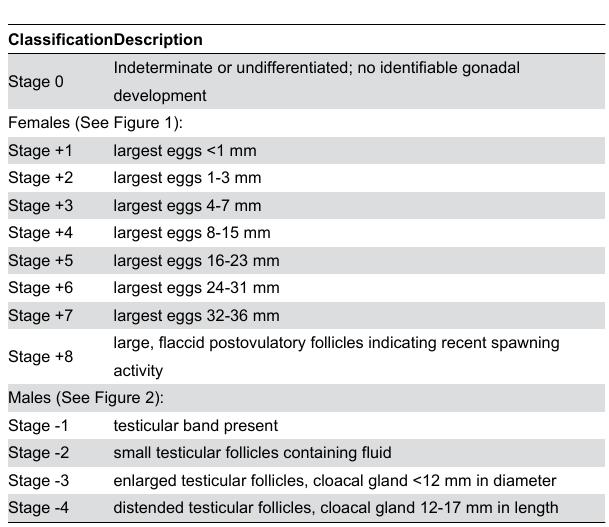
Table 1. Stages of Sexual